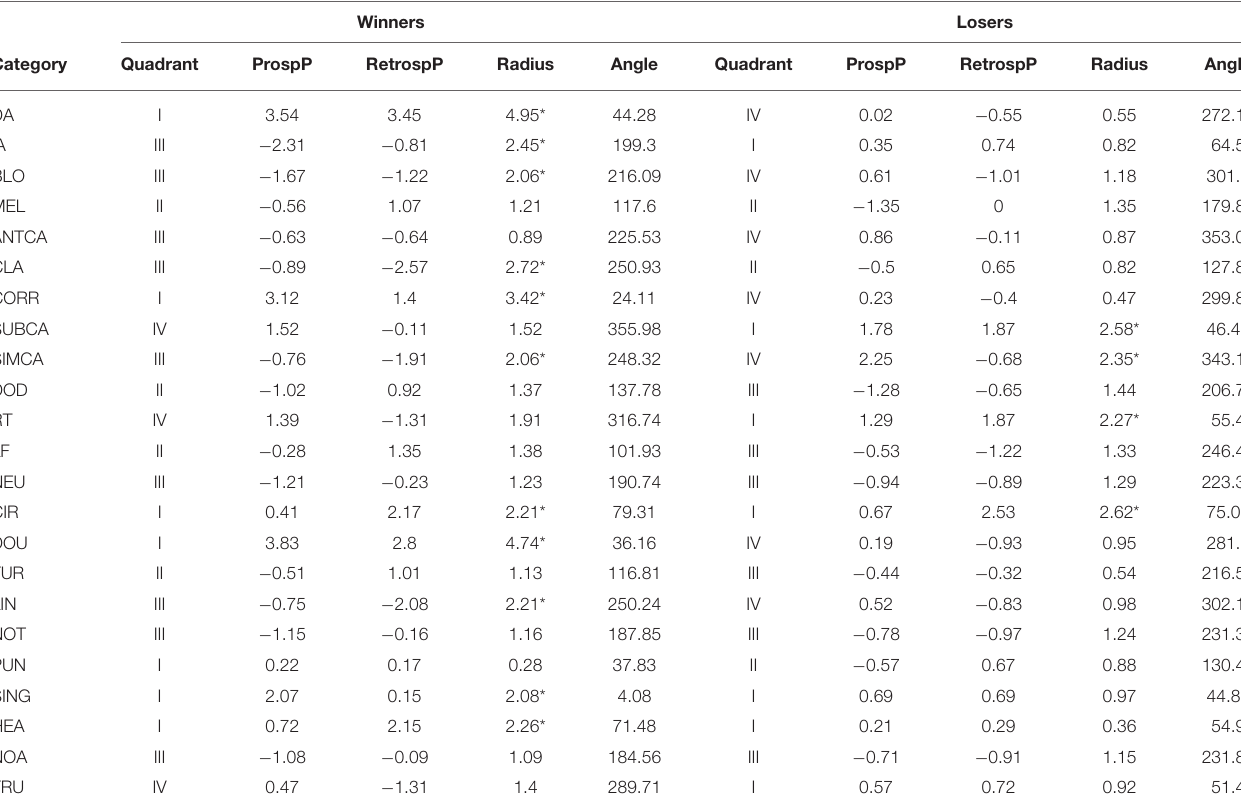
TABLE 5 | Results of the polar coordinate analysis for the 1P focal category in winners and